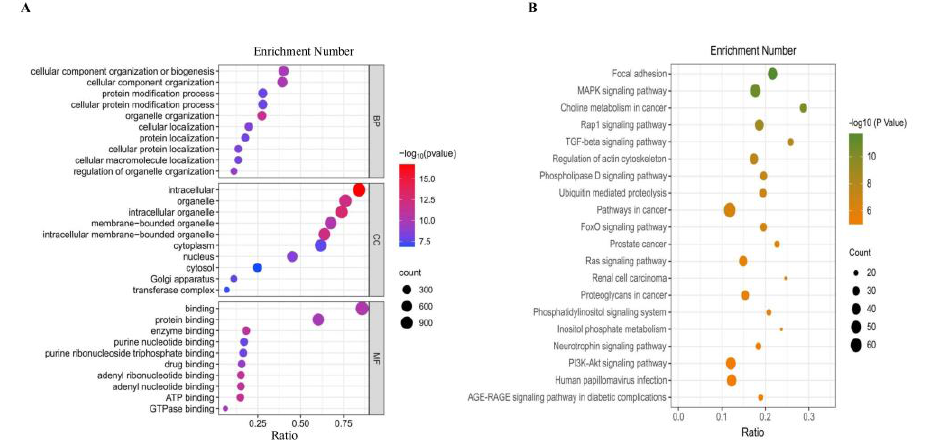
Figure 8. GO and KEGG enrichment analysis of DEcircRNA host genes that may be bound by oar-miRNA-125b ( A ) GO analysis of DEcircRNA host genes in positive vs. negative. The results are summarized in three main categories, BP, CC and MF. ( B ) KEGG analysis of DEcircRNA host genes in positive vs. negative.